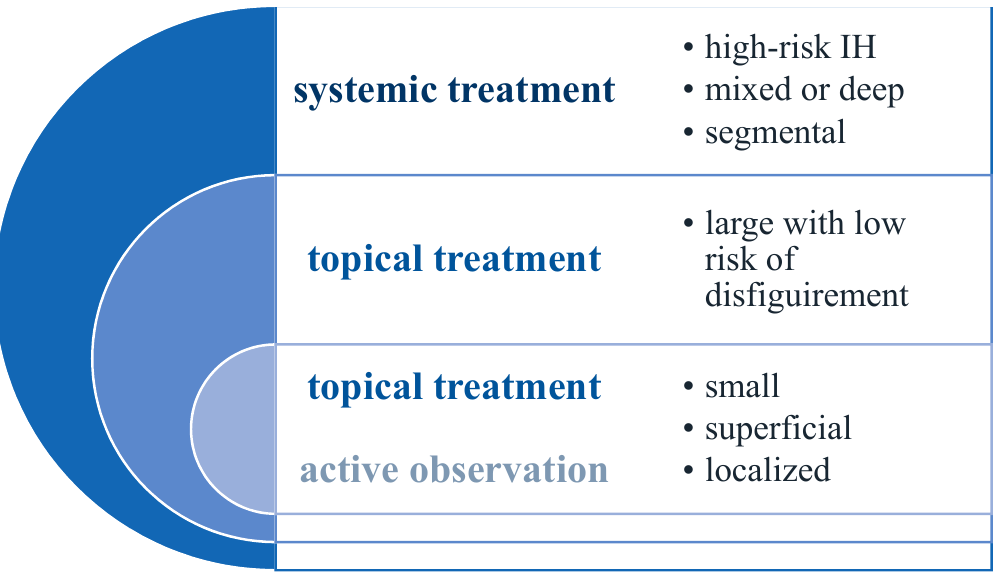
Figure 2. Treatment indications considering size, depth, and the morphological character of infantile hemangiomas.